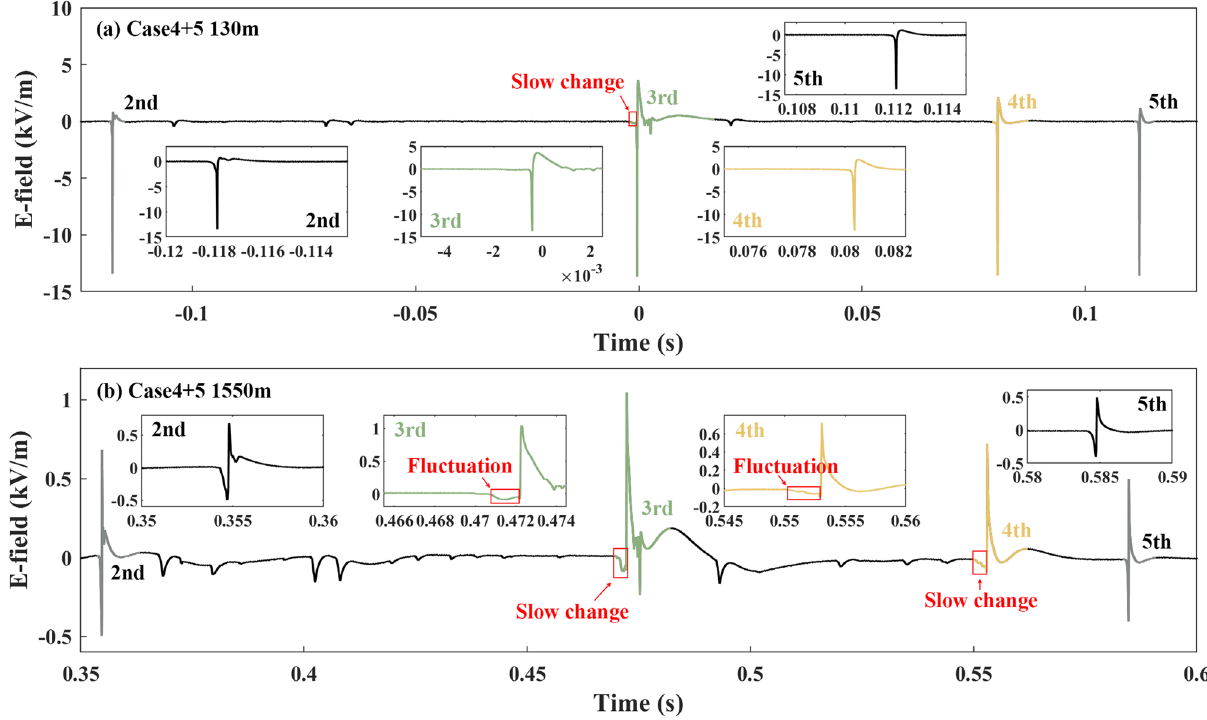
Figure 5. The E-field waveforms of Cases 4 and 5, along with their previous and subsequent downward leader– return stroke